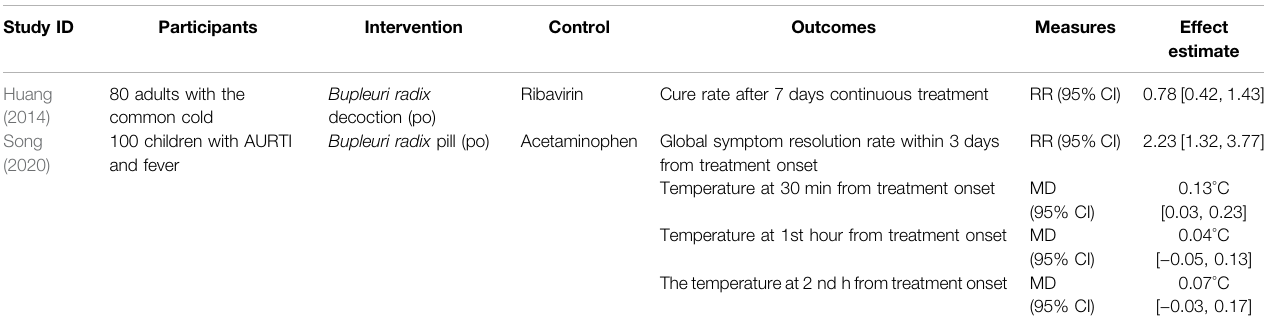
TABLE 4 | Bupleuri radix versus usual care (2